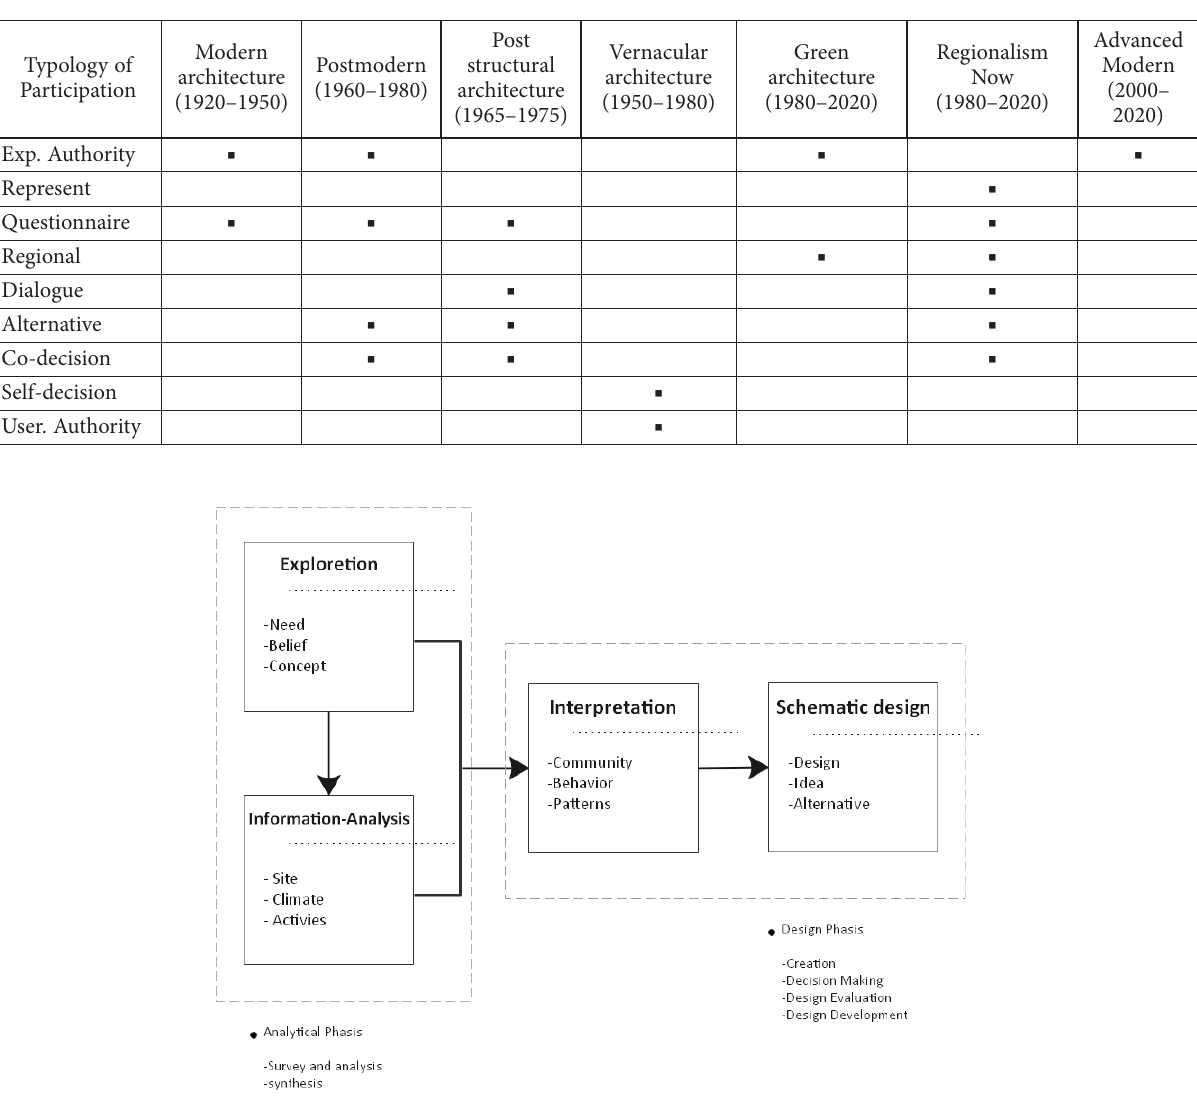
Figure 3. A general model of CA design process (source: